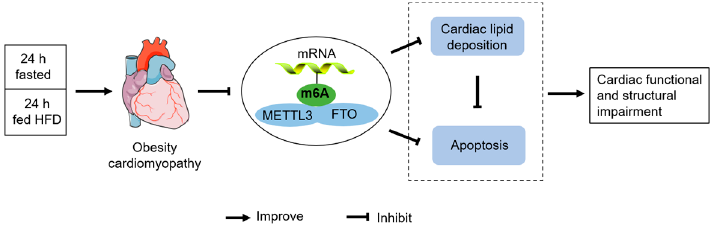
Figure 7. A possible mechanism for IF to improve obesity cardiomyopathy induced by HFD.